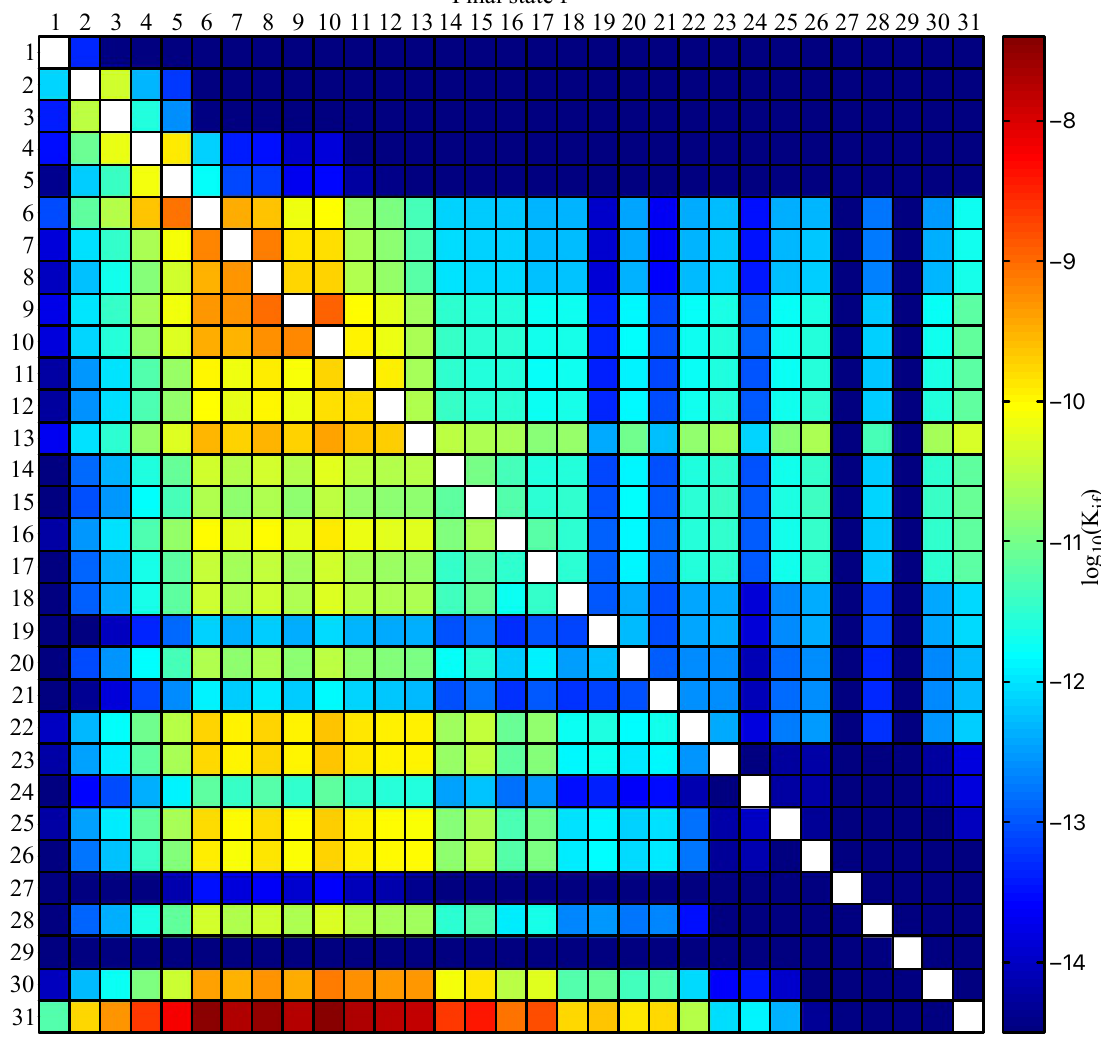
Figure 1. The graphical representation for the inelastic processes rate coefficients in Sr + (cid:1) + ) and Sr 2 + (cid:0) 4 p 6 1 S H ( 1 s 2 S 1 / H − ( 1 s 2 1 S 0 ) collisions at the temperature T = 6000 K. The labels for 0 2 the initial and final states are given in Table